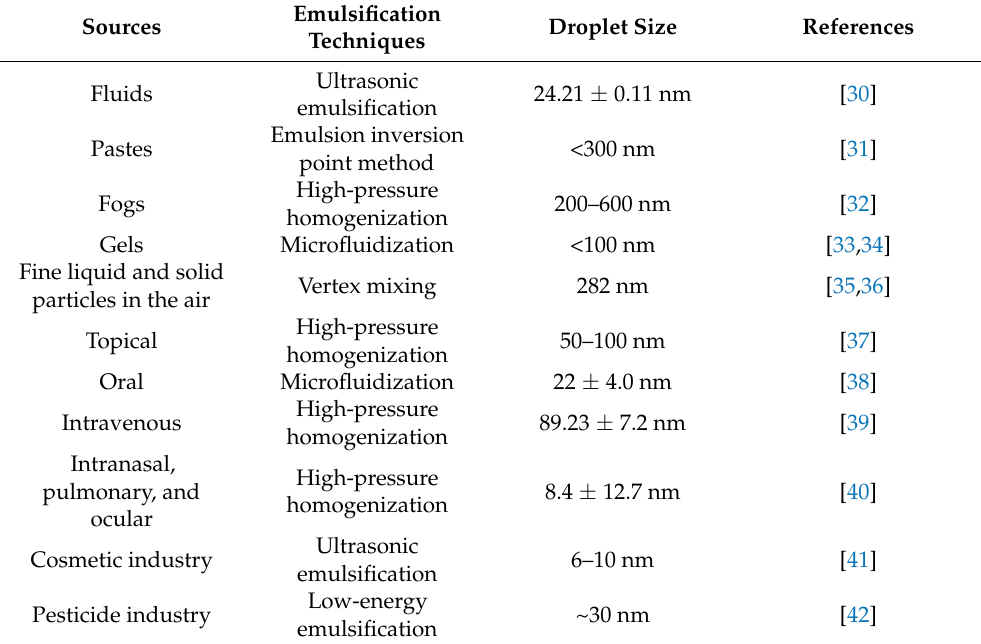
Table 3. Comparison of nanoemulsion with droplet